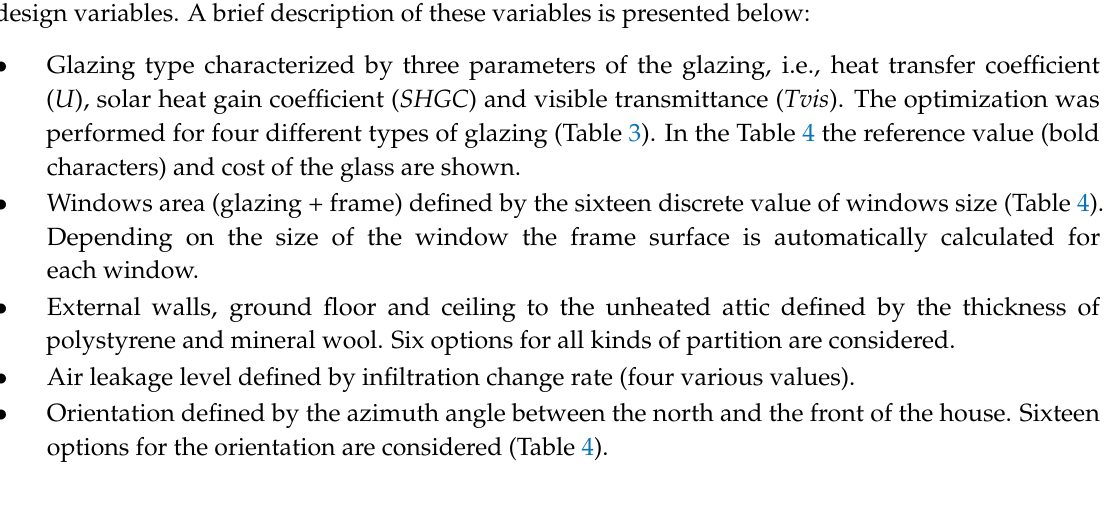
Table 3. Visible and solar energy parameters of the